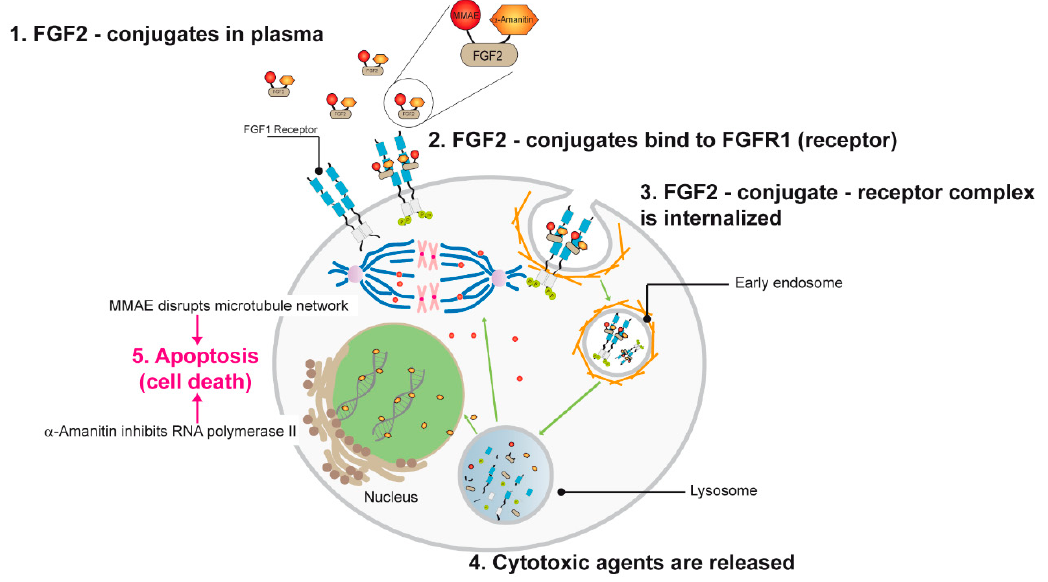
Figure 7. Proposed mechanism of action for α -amanitin/MMAE-FGF2 conjugate. After binding to the high affinity FGFRs on the cancer cell surface dual FGF2 conjugate is internalizing by endocytosis. Processing through the endosome–lysosome pathway leads to release of MMAE and α -amanitin inside the cell and next respectively inhibit tubulin polymerization and DNA transcription.